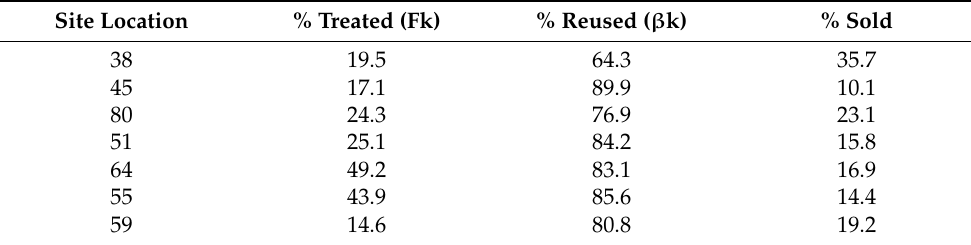
Table 5. Optimal fraction for the treatment of wastewater for reuse: network in Figure 3.